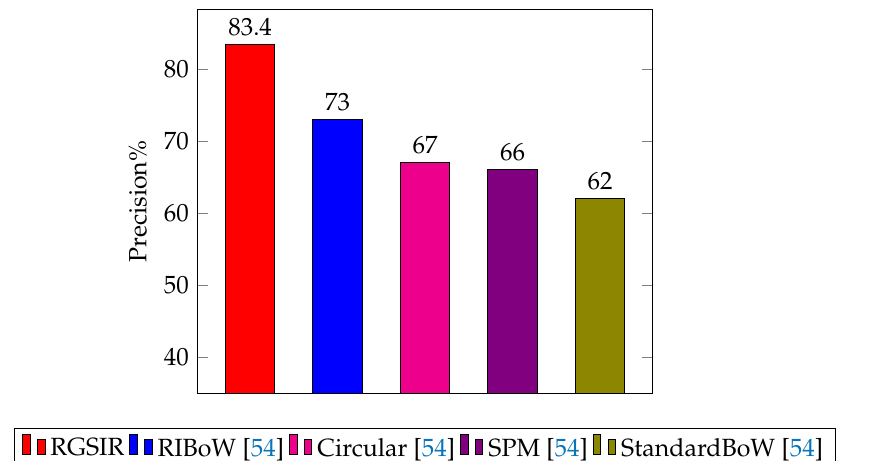
Figure 21. Average precision comparison of the proposed RGSIR with the state-of-the-art approaches for the Corel-1K image